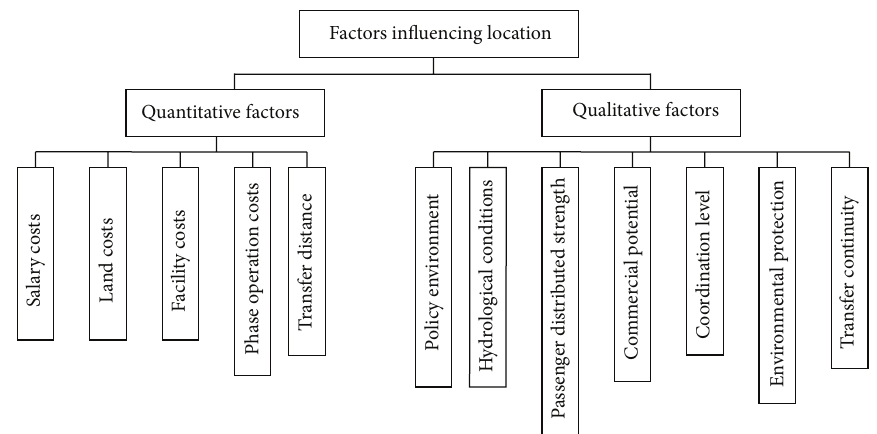
Figure 1: Factors that influence public transportation hub location.